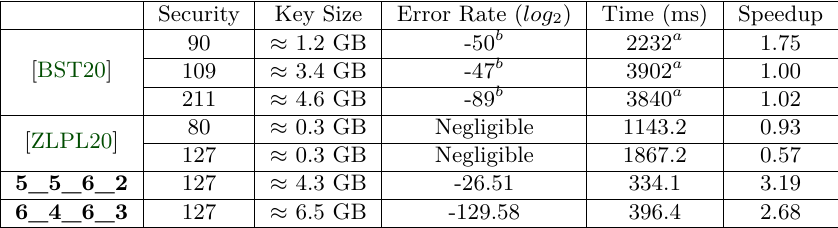
Table 5: Comparison between implementations of a 32-bit integer comparison.